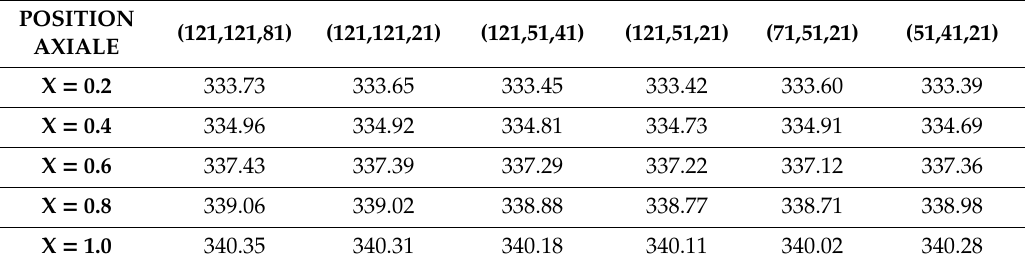
Figure 2. Validation of the code simulation. Interfacial temperature – comparison with Yan et al. [17]. Table 1. Stability of calculation from a mesh variations-interfacial temperature.